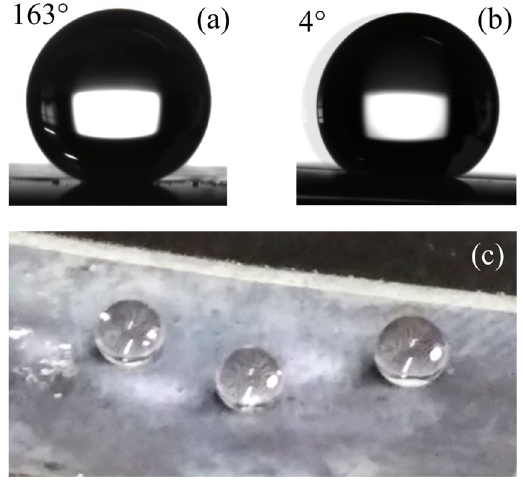
Figure 6. The contact angle ( a ), sliding angle ( b ) and optical image ( c ) of the processed